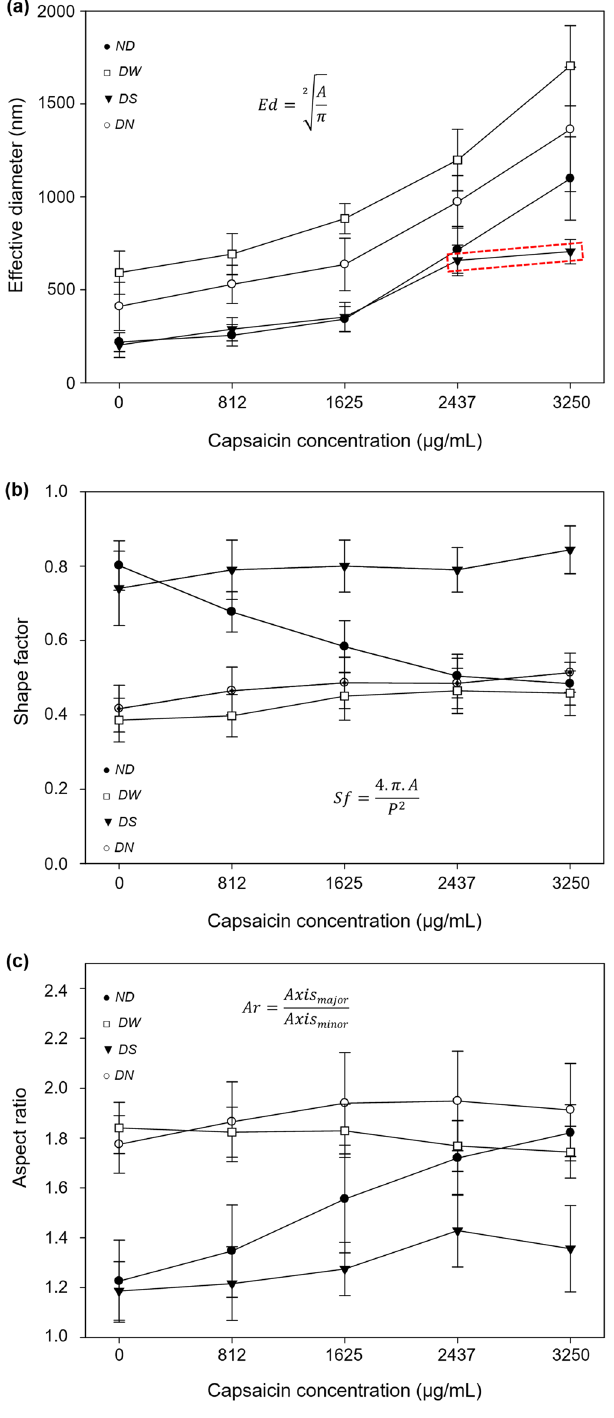
Figure 5. ( a ) Effective diameter parameter of isolated BSA-capsaicin nanoparticles versus capsaicin concentration for different drying procedures. The DS treatment showed a protective effect that allowed to reduce the size of nanoparticles at a high concentration of capsaicin. ( b ) The isolated nanoparticles showed a gradual loss of shape compared with NPs without drying (ND) treatment as a function of initial capsaicin concentration. DW and DN treatments did not show protective effect in any formulation. DS showed a protective effect and increase of the circular shape ( Sf = 1). The equation of shape factor ( Sf ) is also displayed. ( c ) Aspect ratio of BSA-nanoparticles versus capsaicin concentration. ND treatment resulted in a gradual transition from circular to ellipsoidal shape. DW and DN did not show a protective effect in all formulations. The NS treatment showed a protective effect that reduced the change to elliptical shape at a high concentration of capsaicin (3250 μg mL −1 ). Values are means of three experimental replicates ± standard